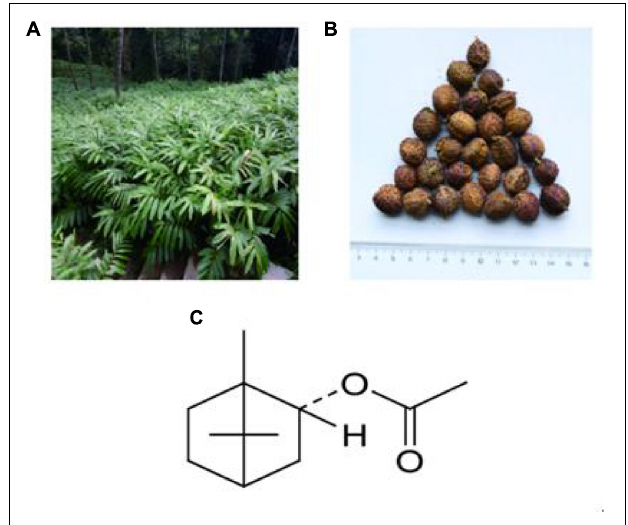
FIGURE 1 | Plants used: (A) Amomum villosum Lour.; (B) fruit of A. villosum Lour.; and (C) structure of BA, the main constituent of VOA.